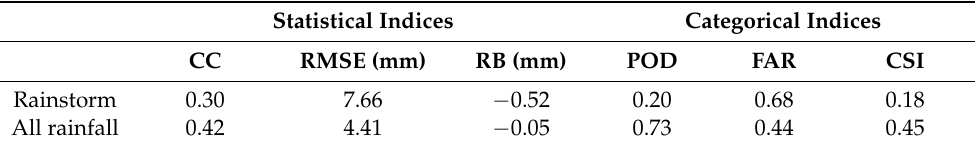
Table 1. Performance comparison of IMERG LR in rainstorms and all rainfall events.